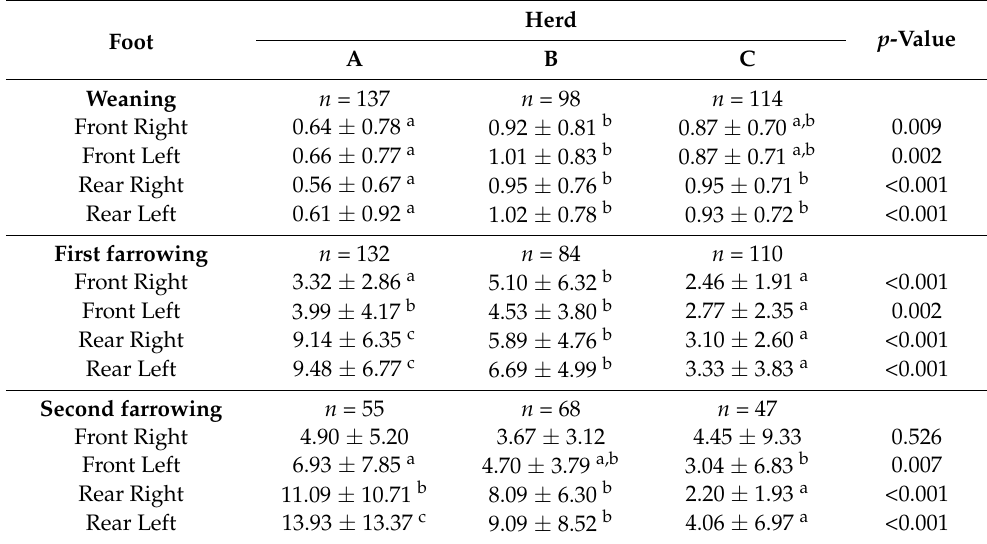
Table 5. Results of anisodactylia (mm) (mean ± SD) in replacement gilts of different genetic lines in three farrow-to-finish herds in Greece, at weaning age and at first and second farrowing. Herd p -Value Foot A B C Weaning